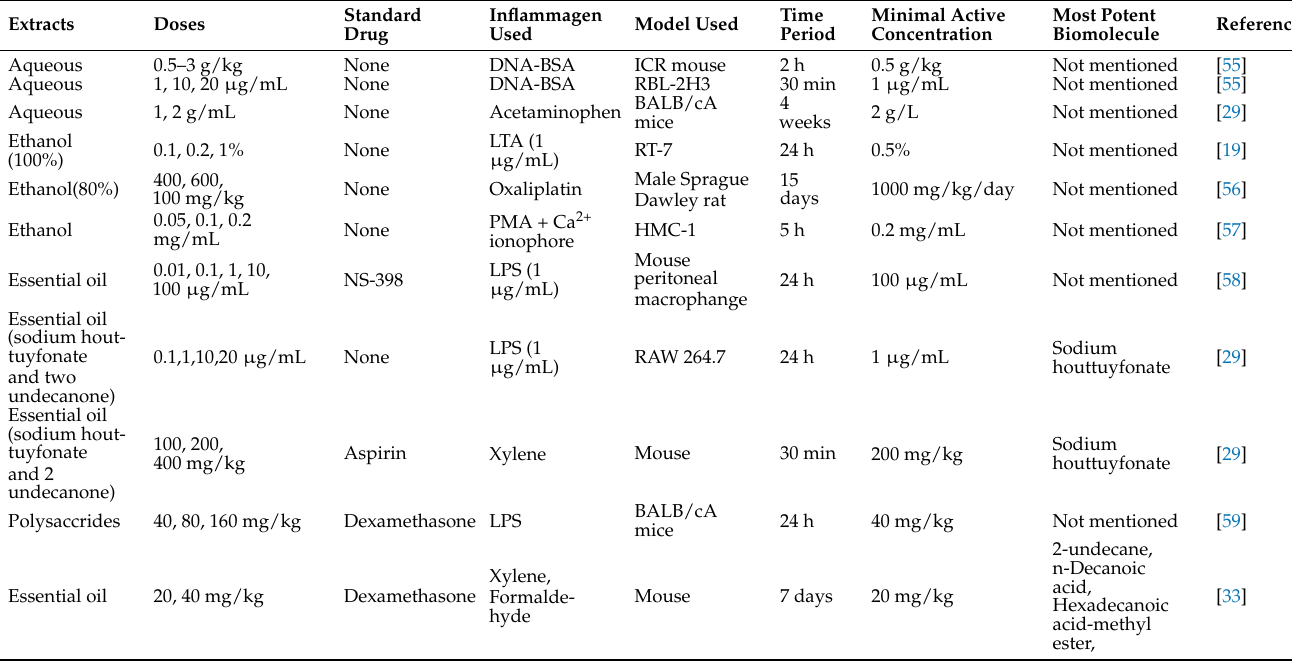
Table 2. Different extracts of H. cordata to treat inflammation in vitro and